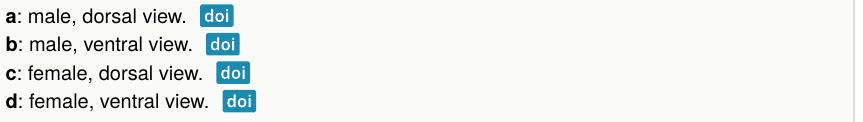
Habitus of Caystrus orientalis from Japan. Scale bar 5.0